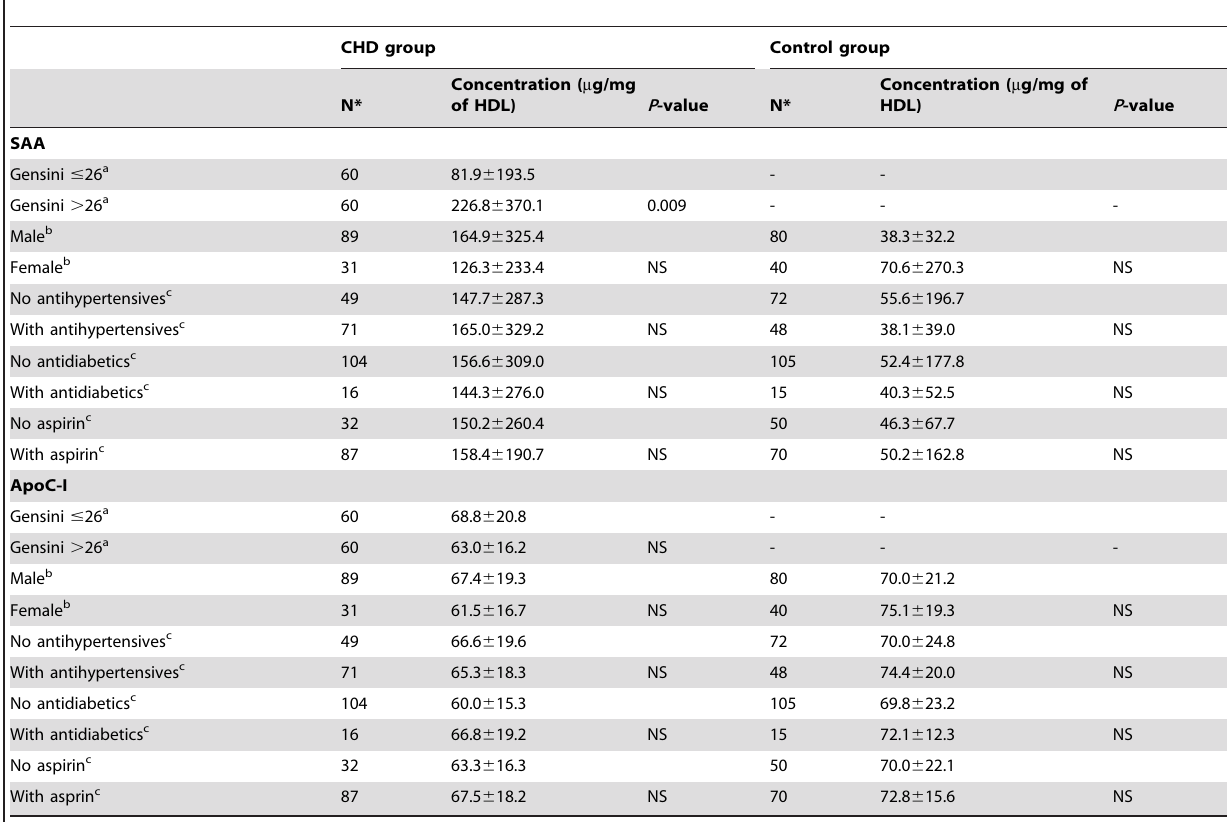
Table 4. Differential expression levels of HDL-associated SAA and ApoC-I in independent CHD and control validation study